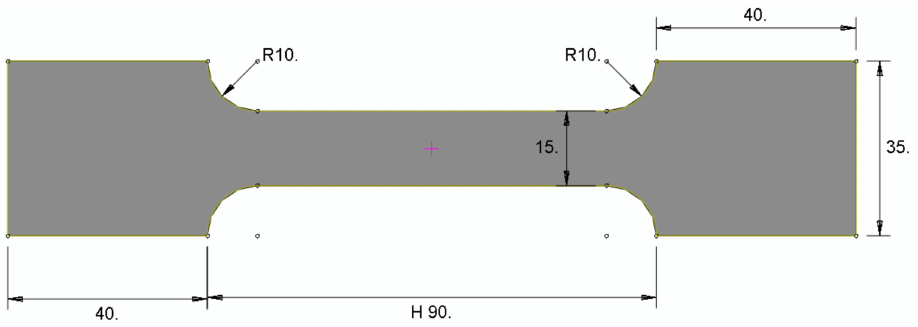
Figure 6. Tensile test specimen